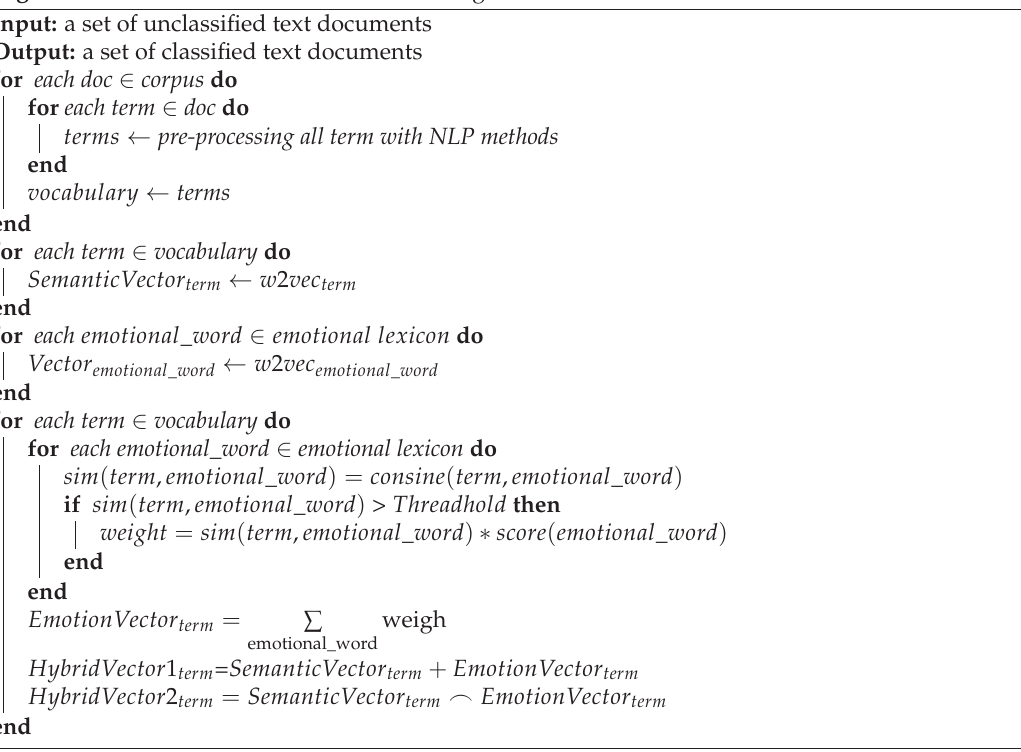
Algorithm 1 sentiment-aware word embedding for emotion